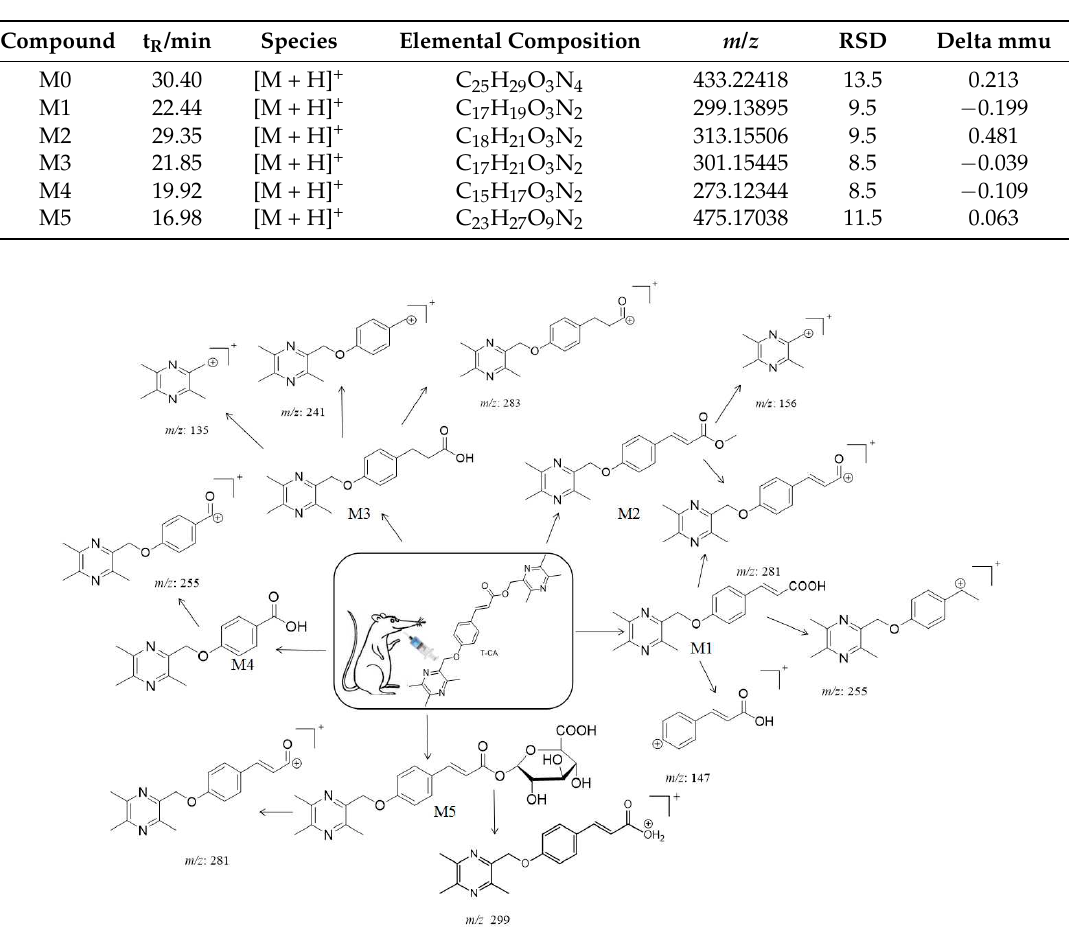
Table 1. Retention time, accurate mass, elementary composition, and precision of metabolites.